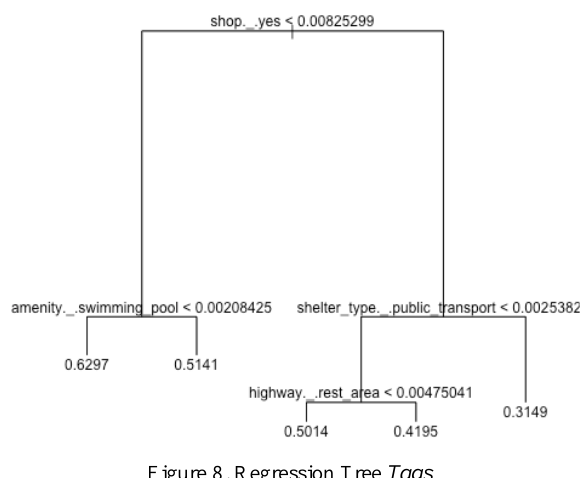
Figure 8. Regression Tree